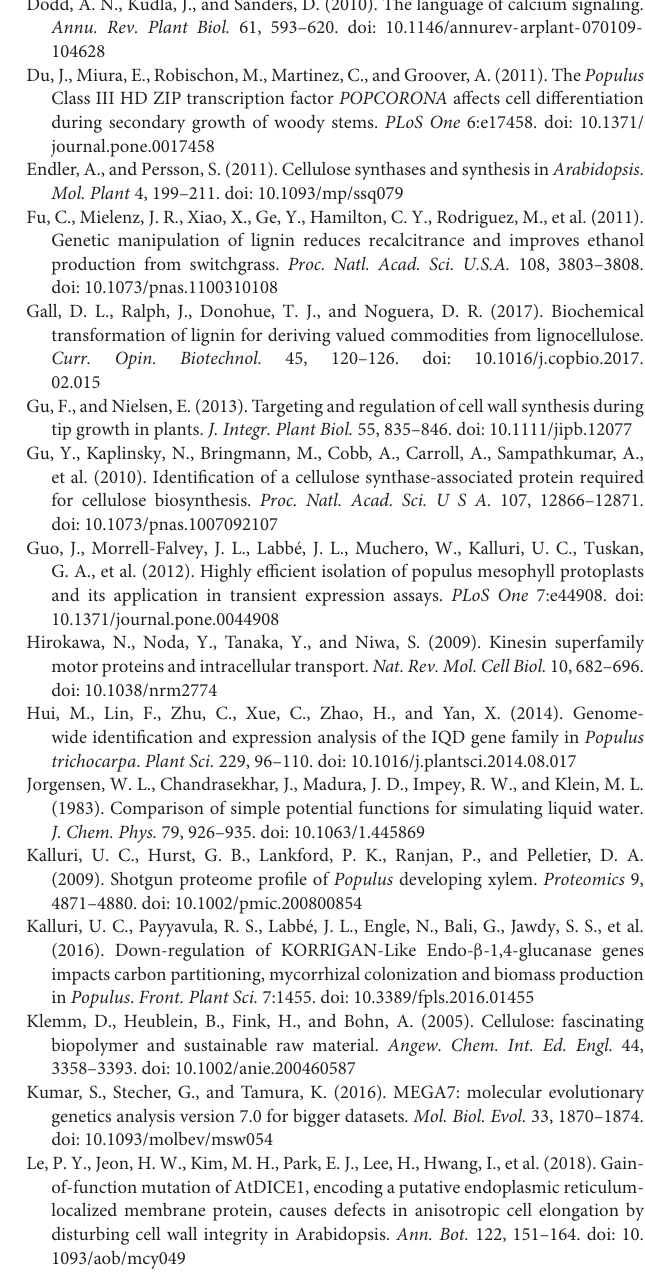
FIGURE S8 | Yeast two-hybrid interaction analysis of PdIQD10 with proteins from co-expressing genes. Yeast two-hybrid interaction analysis of PdIQD10 with putative interacting proteins chosen from the database analysis results. Bar graph on the right represents the average β -galactosidase activities assayed from three independent yeast colonies to determine the strength of the interactions. FIGURE S9 | Expression analysis of PdIQD10 gene in various Populus tissues. This figure is the original version of Fig1b showing the continuous Y-axis scale. FIGURE S10 | Original RGB subcellular localization images used to generate accessible images in Figure 4 and Supplementary Figure S6